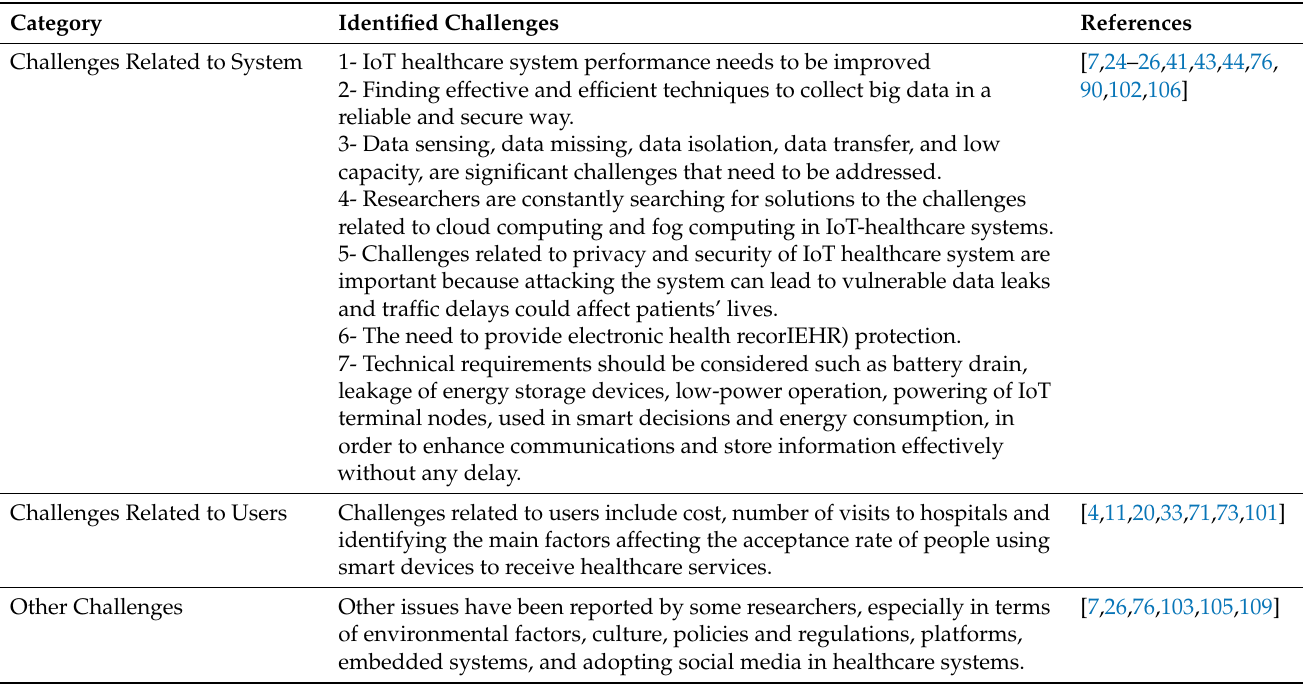
Table 3. Summary of common challenges.